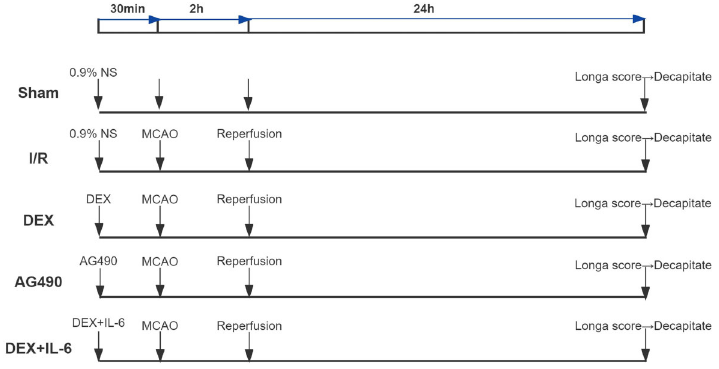
Figure 1. Experimental groups and protocols. MCAO: middle cerebral artery occlusion; I/R: ischemia/reperfusion; DEX: dexmedetomidine; NS: normal saline; IL-6: